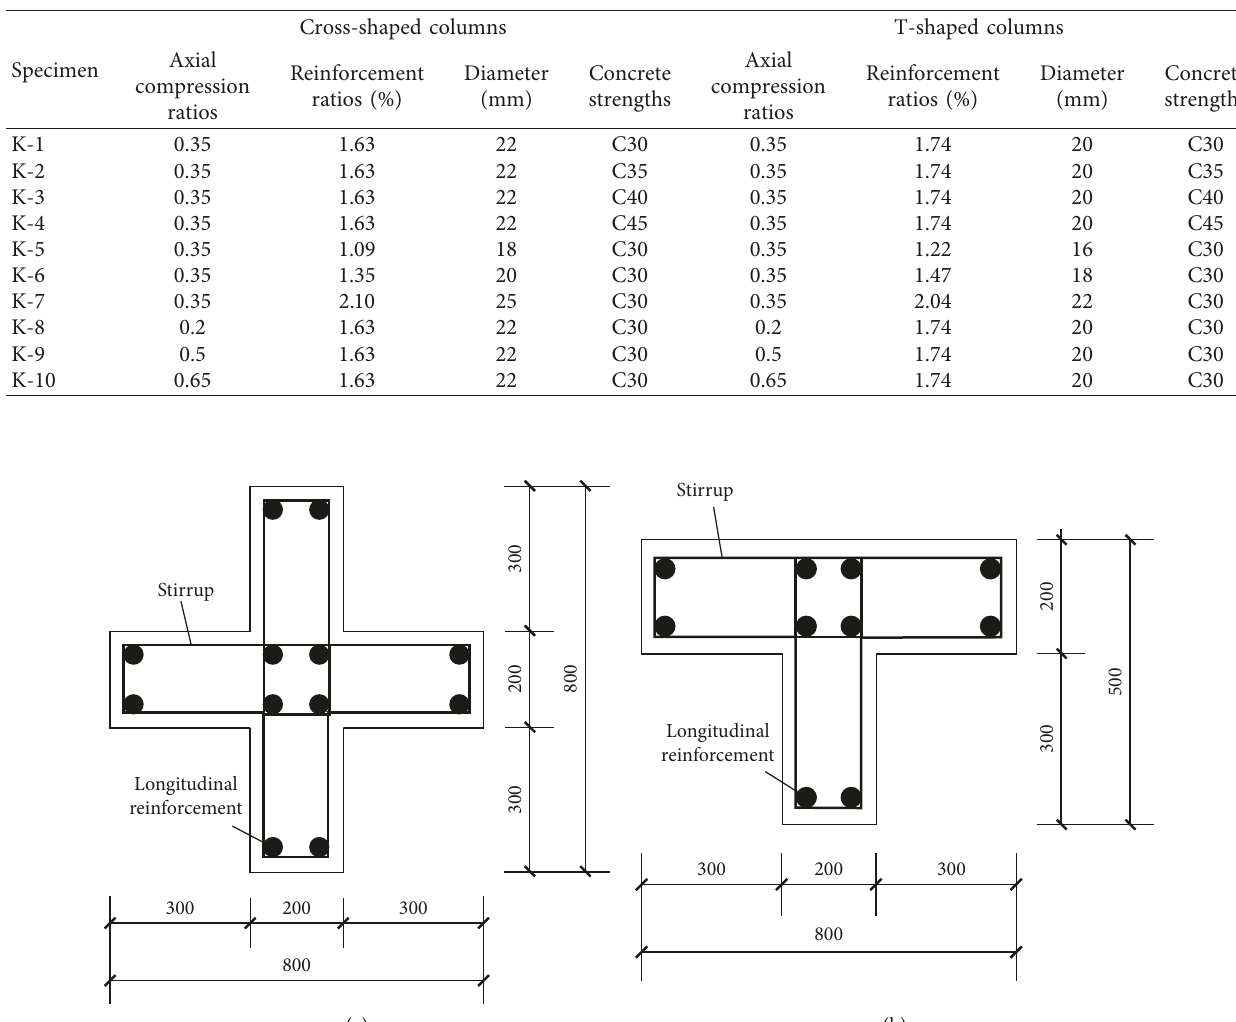
Table 1: Parameters of the simulated specimens.